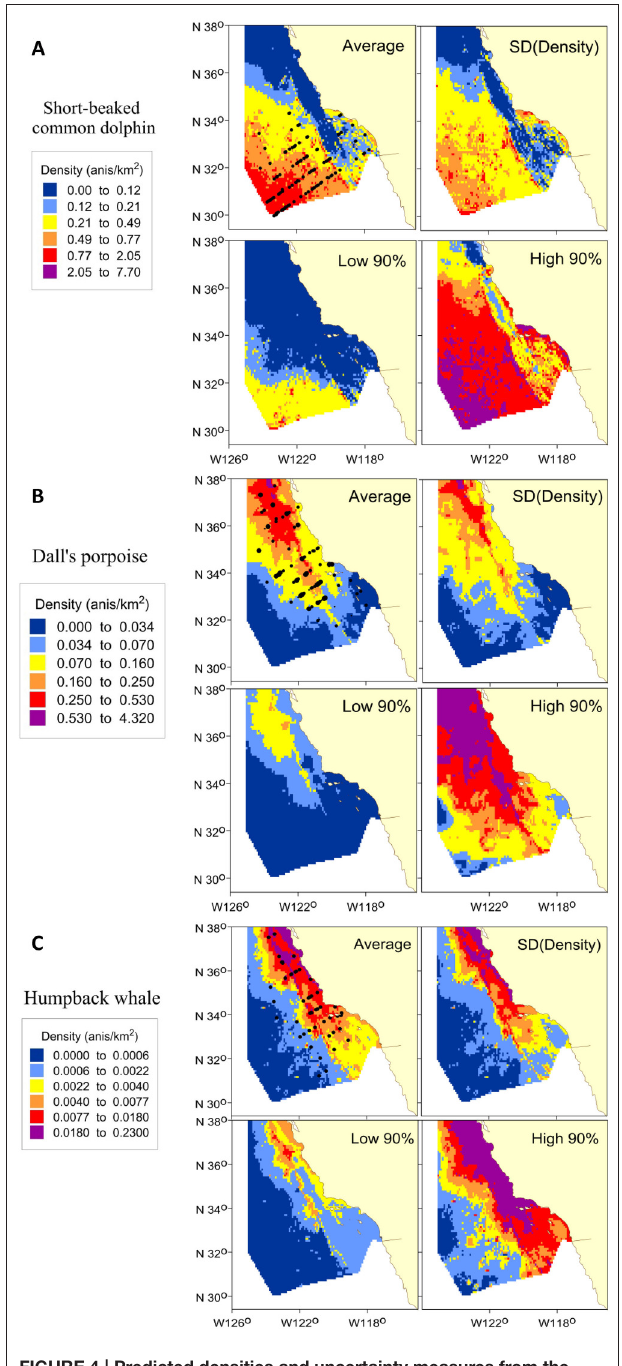
FIGURE 4 | Predicted densities and uncertainty measures from the winter/spring habitat-based density models for (A) short-beaked common dolphin, (B) Dall’s porpoise, and (C) humpback whale. Panels show the multi-year average (Average) density based on predicted 8-day cetacean species densities covering the survey periods (winter/spring 2005–2015), as well as the standard deviation of density [SD (Density)], and the 90% confidence limits (Low 90% and High 90%). Density ranges were selected to encompass all values within the confidence limits. Predictions are shown for the study area (385,460 km 2 ). Black dots in the average plots show actual sighting locations from the CalCOFI winter/spring ship surveys for the respective